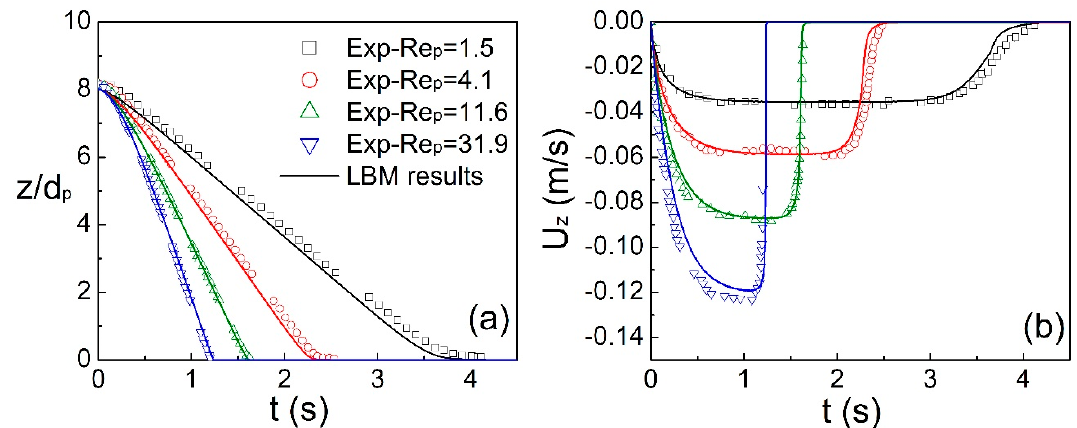
Figure 10. ( a ) Particle trajectory and ( b ) velocity profiles as a function of time.